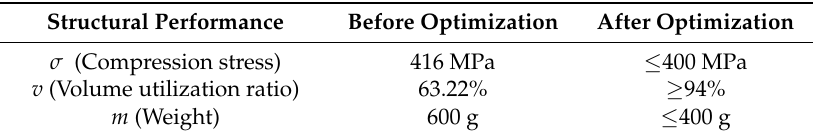
Table 6. Optimization target of structural performance of the improved storage tank with a square column structure. Structural Performance Before Optimization After